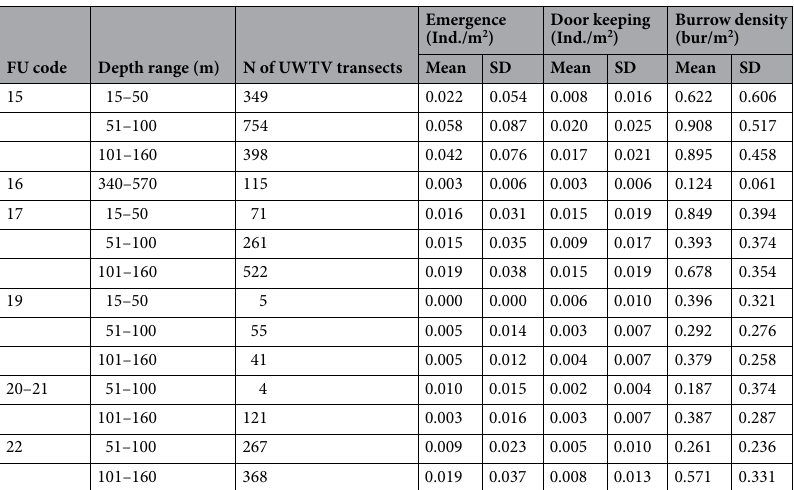
Table 2. Time-independent density of animals (Ind./m 2 ) at emergence and door-keeping per depth range by Nephrops functional units